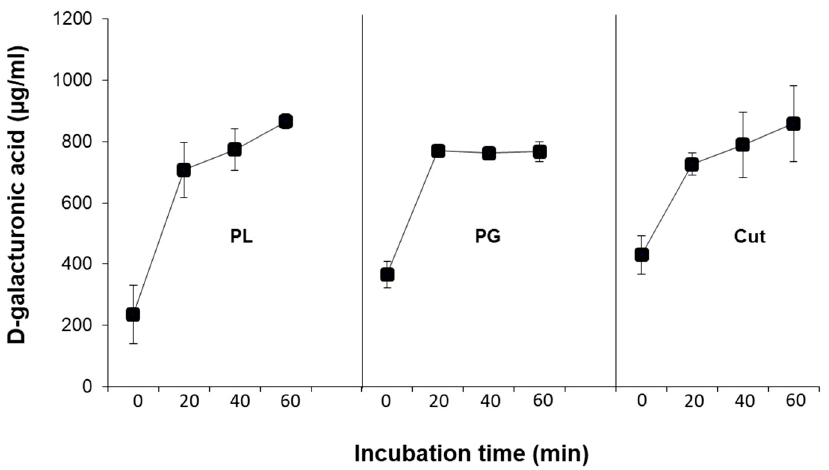
Figure 4. Tracking the concentration changes over time of D-galacturonic in the reaction mixture of natural cotton fabrics and cutinase (Cut), pectin lyase (PL), or polygalacturonase (PG). Initial enzyme activity was as follows: 0.7 U/mL of Cut, 1.0 U/mL of PL and 0.5 U/mL of PG. The enzymatic treatment was carried out by incubating one dry and weighed swatch of fabric in the reaction solution at a 1 gr cloth/10 mL ratio in 15 mL polycarbonate test tubes. The reaction mixture contained a non-ionic detergent (AvcoPal-AWS) 0.1% ( w / v ), a 100 mM phosphate buffer, pH 8 for cutinase and PL and 50 mM acetate buffer, pH 5 for PG and the corresponding enzyme. Incubation was performed by placing the test tubes diagonally in a rotary shaker and rotating them at 175 rpm and 37 °C for the indicated times. Values represent an average of three independent replicates. Bars indicate standard deviation.